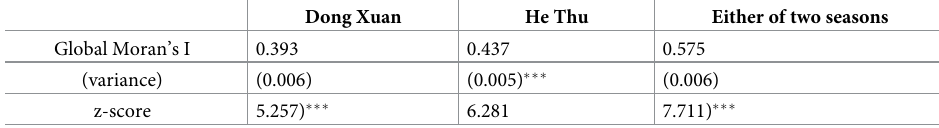
Table 3. Global Moran’s I by type of